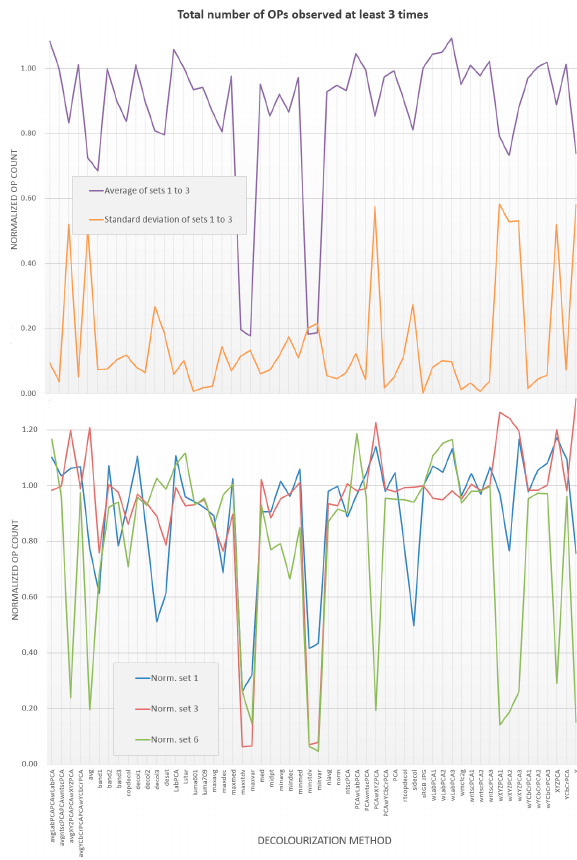
Figure 6. Total number of OPs that have been observed at least three times (SIFT), normalized to